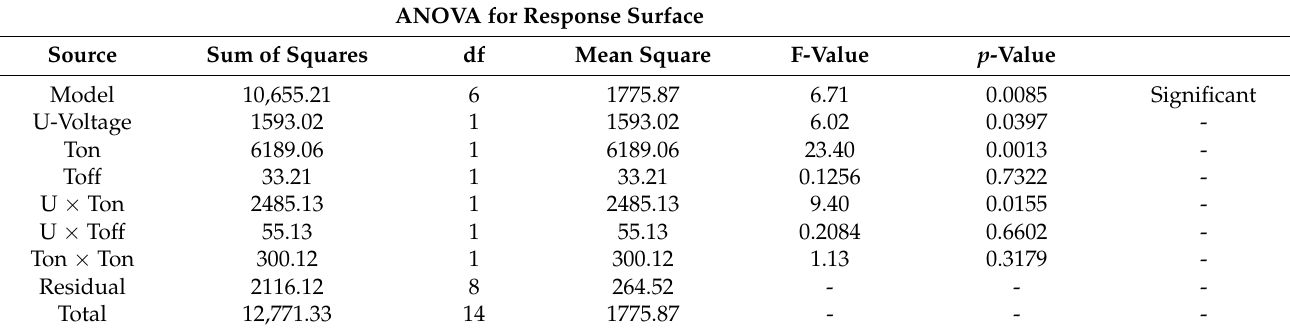
Table 5. Analysis of variance (ANOVA) of process parameters for 2-way interaction model. ANOVA for Response Surface